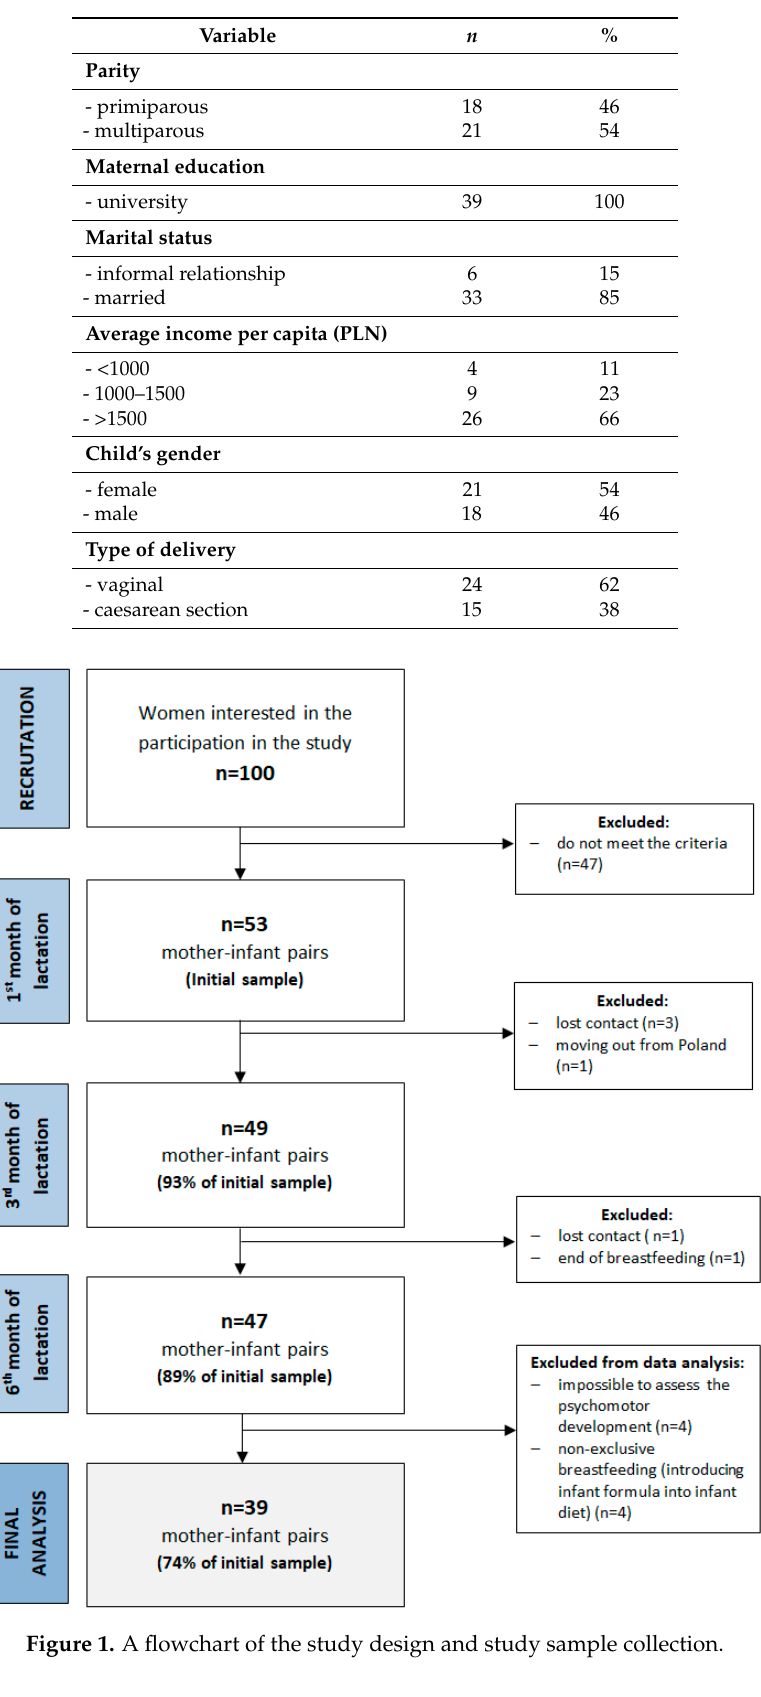
Table 2. The study group characteristics: qualitative variables.